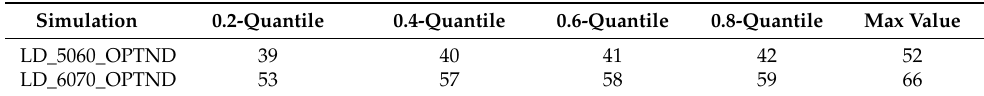
Table 2. Values of selected quantiles for simulations carried out in scenario 2.